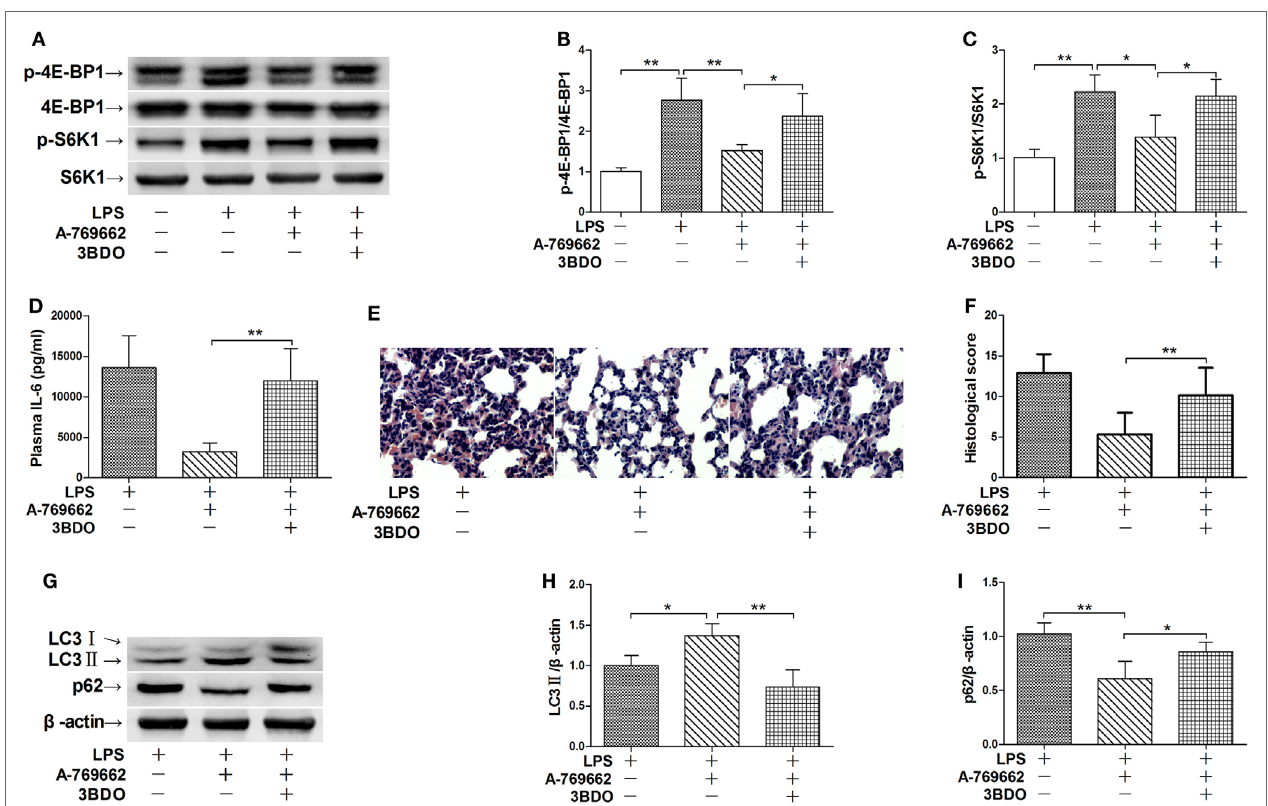
FigUre 4 | Activation of mammalian target of rapamycin (mTOR) reversed the suppressive effects of AMP-activated protein kinase (AMPK) activator on inflammatory injury and autophgay. Mice were exposed to lipopolysaccharide (LPS) (20 mg/kg) with vehicle, AMPK activator A-769662, and mTOR activator 3BDO administration. The level of phosphorylated 4E-BP1 (p-4E-BP1), total 4E-BP1 (4E-BP1), phosphorylated S6K1 (p-S6K1), and total S6K1 (S6K1) was determined by immunoblot (a) , and the blots were semi-quantified (B,c) ( n = 4). The plasma level of interleukin 6 (IL-6) was determined by enzyme-linked immunosorbent assay (D) ( n = 8). The histological abnormalities of the lung tissue were observed with hematoxylin & eosin staining. The representative lung sections of each group were shown (e) , the histopathological alterations were blindly scored (F) . The level of LC3II and p62 was determined by immunoblot (g) , and the blots were semi- quantified (h,i) ( n =